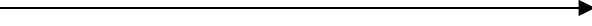
and P 1 2 corresponds to 1